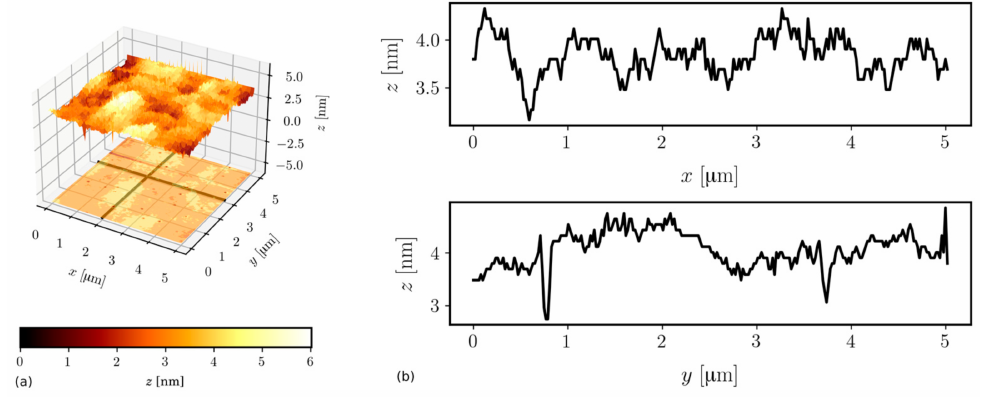
Figure 5. An AFM image ( a ) and roughness profiles ( b ) of the Wg1 waveguide.